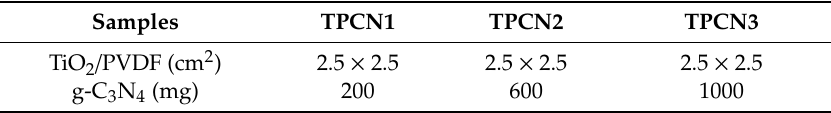
Table 1. TiO 2 / PVDF / g-C 3 N 4 (TPCN)